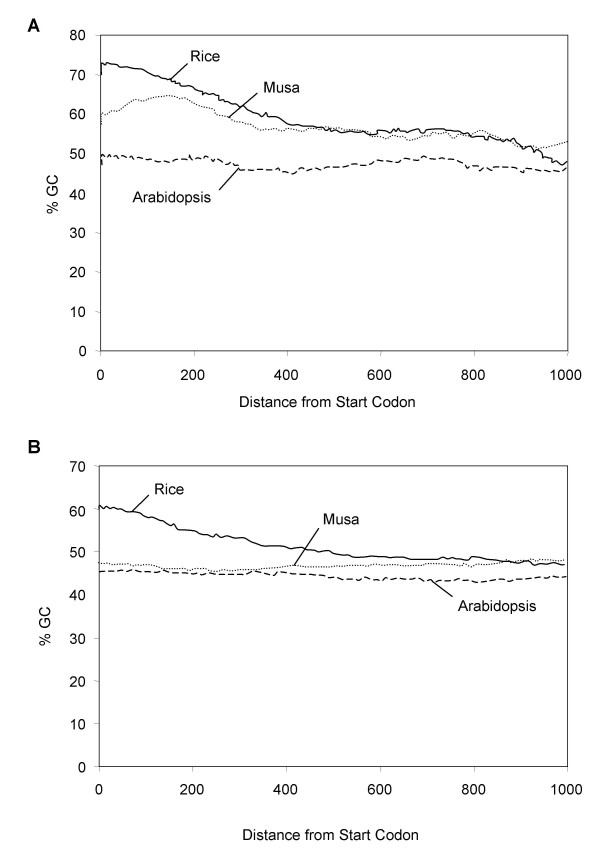
Mean GC content from 5' to 3' across 129 bp sliding windows. (A) for 77 Musa genes with a "rice-like" gradient. (B) for 180 Musa genes with an "Aradidopsis-like" pattern